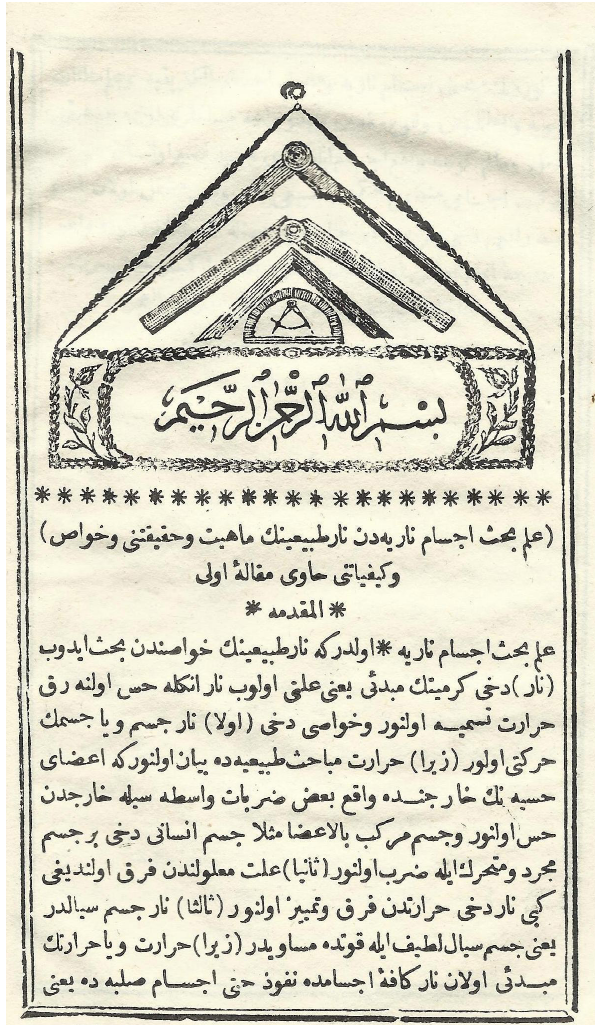
Figure 3b. Cover page of Mecmua-i Ulum-i Riyaziye (Collection of Mathematical Sciences) written by Hoca Ishak Efendi in 1750 (from my own